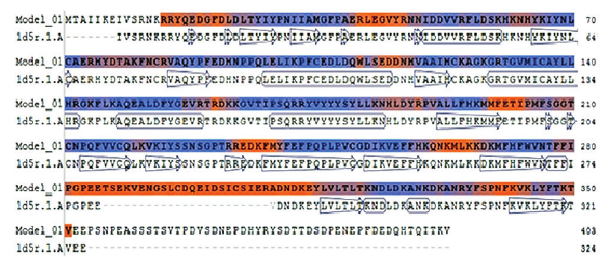
figurE 5 − PTEN protein [ Homo sapiens ] – model – template alignment